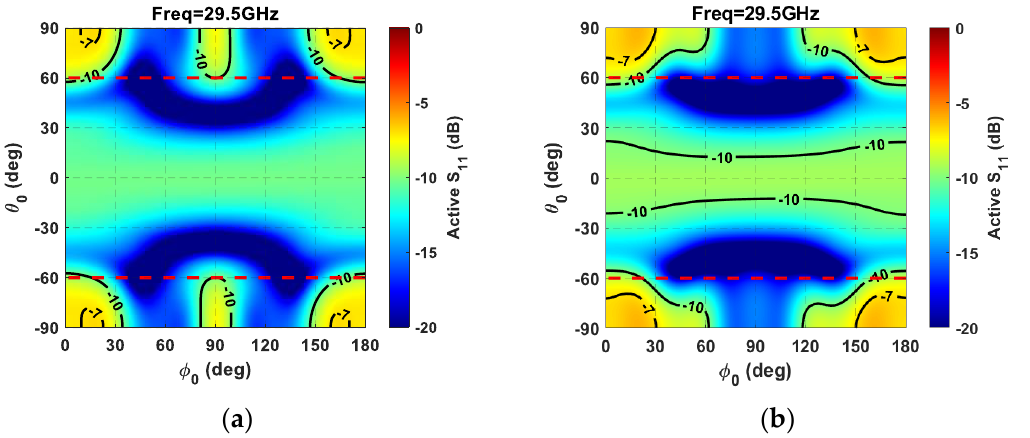
Figure 14. Active S 11 parameter related to the central array element as a function of beam steering for a planar array composed of 64 elements with ( a ) a triangular lattice; and ( b ) a square lattice.